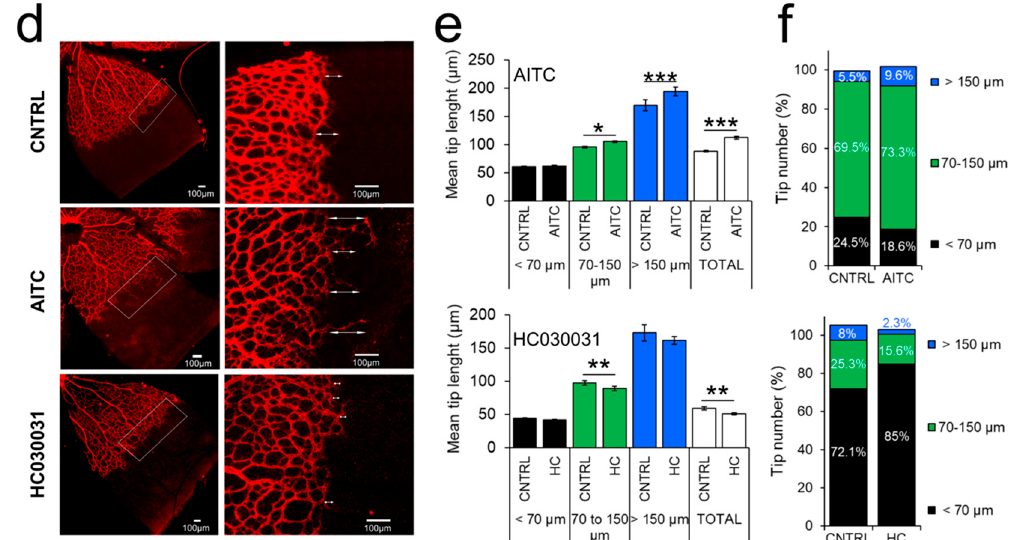
Figure 7. TRPA1 promotes in vitro tubulogenesis and in vivo angiogenesis. ( a ) left panels: TRPA1-overexpressing HMEC display increased in vitro tubulogenesis in Matrigel compared to control cells; right panels: TRPA1-downregulating hTERT PTEC display decreased in vitro tubulogenesis in Matrigel/collagenI substrate compared to control cells; bar graphs show the quantification of number of master segment and the number of isolated segments of control HMECs and TRPA1-overexpressing HMECs. Three independent experiments were performed 24 h after overexpression or after II oligofection pulse. ( b ) Endogenous TRPA1 is diffusely expressed in postnatal mouse retina but clearly co-localizes with CD31 staining, indicating that TRPA1 is found in ECs. ( c , upper panel): analysis of CD31 levels by qPCR in a fraction of CD31-enriched cell population isolated from the mouse retina (CD31+) compared to the depleted cell population (CD31 − ); ( c , lower panel): analysis of TRPA1 mRNA expression by qPCR in a fraction of CD3-enriched cell population isolated from the mouse retina (CD31+) compared to the depleted cell population (CD31 − ). Values are expressed relative to actin expression. Statistical significance *: p -value < 0.05, **: p -value < 0.005 and ***: p -value < 0.0005 vs. control. ( d ) Subretinal injection of AITC or HC030031 did not alter the overall development of the vascular plexus 3 days after treatment, but the front of growing vasculature became uneven after injection of the TRPA1 agonist AITC in the subretinal space. ( e , upper panel) This was illustrated by a significant increase of 26.8% in the length of sprouts (white bars): quantification of tip cell length during mouse retinal angiogenesis shows that compared to that in controls, tip cell length increased significantly 3 days post-intravitreous injection of 200 µM AITC. ( e , lower panel ) : Treatment with TRPA1 inhibitor (200 µM HC030031) induced a decrease in tip cell length. Cell lengths were either classified into three groups according to ranges (<70 µm, 70–150 µm, >150 µm) or considered altogether (total). Bars represent the mean ± SEM of each length range or total grouping. ( f , upper panel): Percentage of tip cells with each length range shows that treatment with AITC induces a decrease in the number of short tip cells (<70 µm) and an increase in the number of medium and long tip cells (>70 µm). ( f , lower panel): Inhibition of TRPA1 with HC030031 induces the opposite effect, increasing the number of short tip cells and decreasing the number of medium and long tip cells.